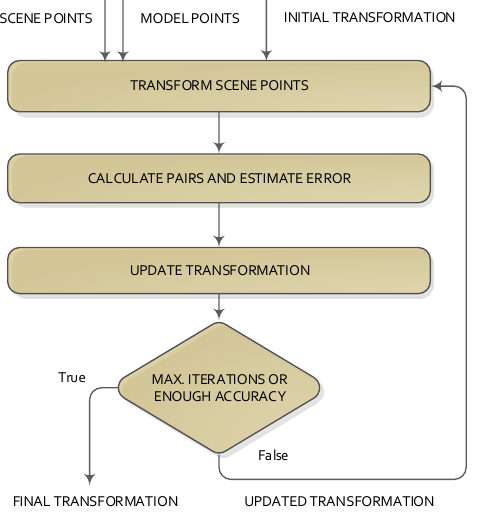
Figure 4. Basic scheme of the iterative closest point